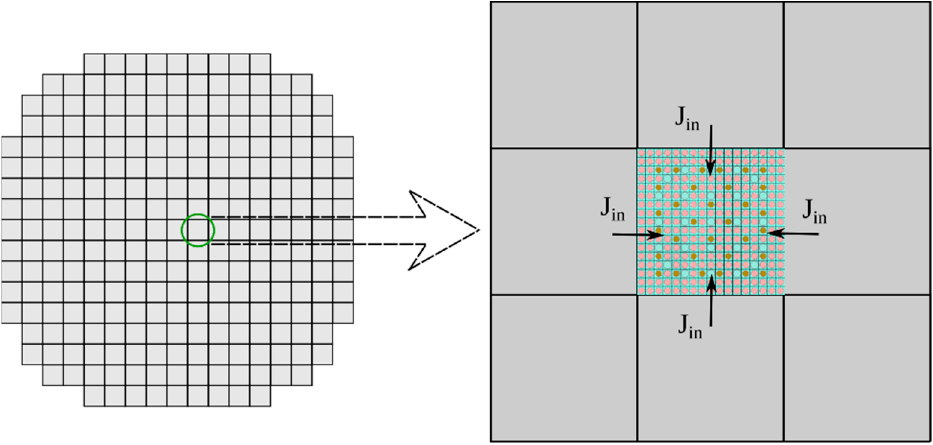
Figure 31. The multi scaling scheme for the smart high ‐ fidelity coupling [28].